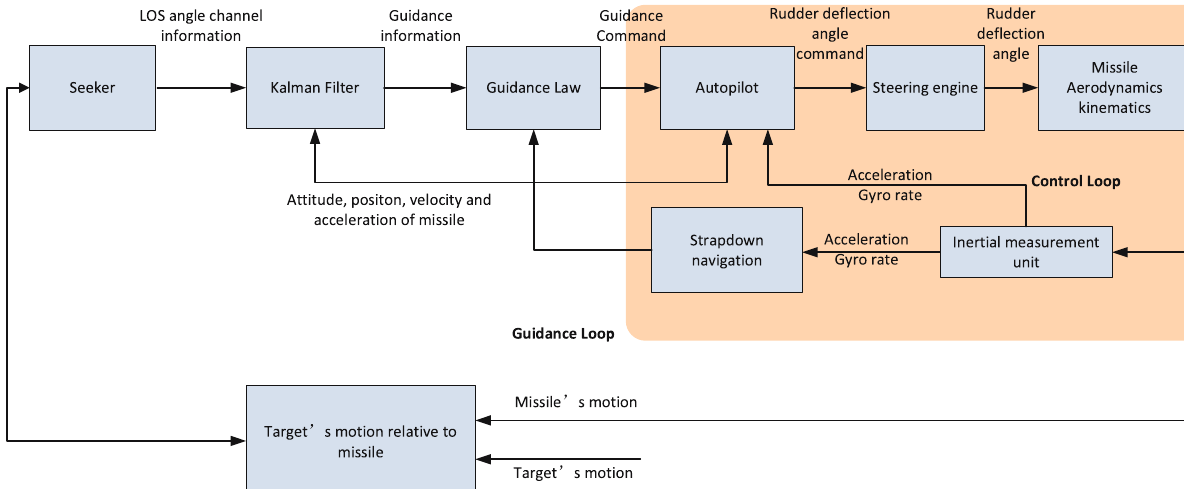
Figure 18: Numerical simulation model of six degrees of freedom guidance system.